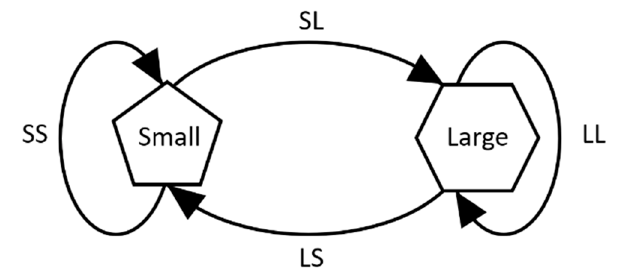
Figure 5. Schematic of a Markov model for internal cage hopping in clathrate hydrate. The diffusion between two large cages or between small cages is labelled as LL and SS, respectively. Diffusion from a large cage to a small cage, and from a small cage to a large cage is labelled LS and SL, respectively.